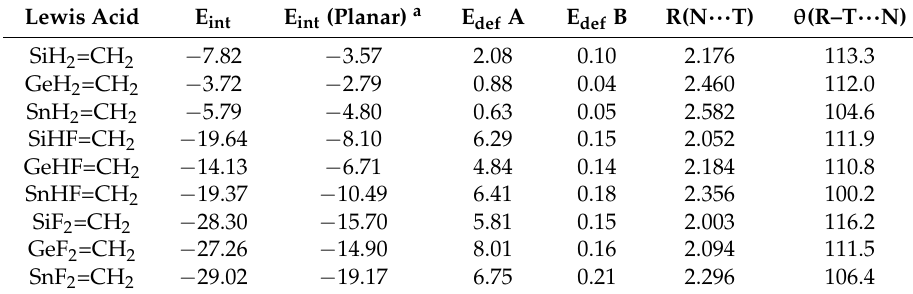
Figure 4. Optimized structures of π -hole bonded tetrel complexes (N—dark blue, T—green, H—white, F—light blue). Table 6. Interaction energy (E int ) corrected for BSSE, subunit deformation energy (E def ), and intermolecular geometrical parameters (energies in kcal/mol, distances in Å, angles in degrees) in π -hole bonded complexes with NH 3 . Data obtained at the MP2 level of theory.